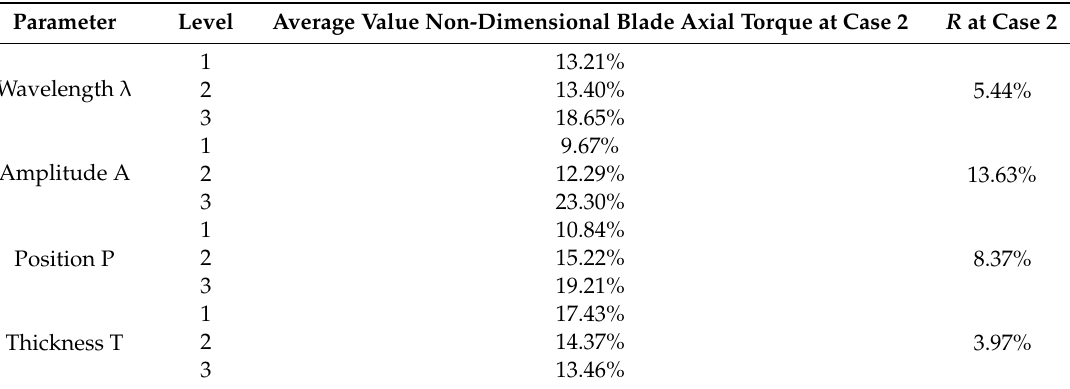
Table 6. The OTM analysis